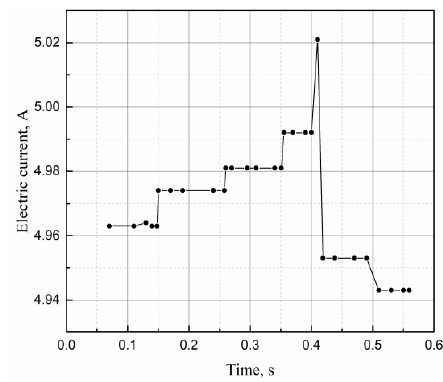
Figure 11. Variation of electric current with time, before and after droplet detachment.